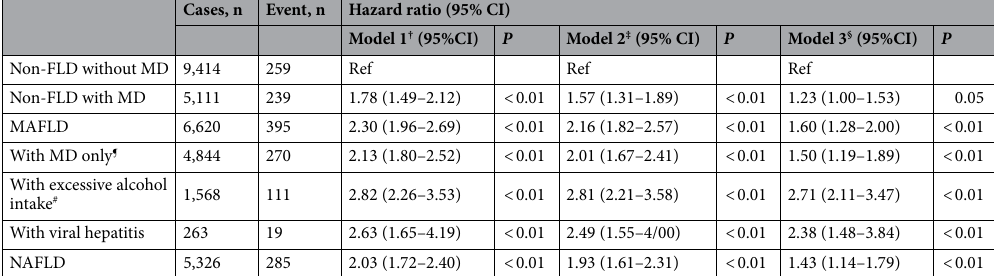
Table 4. Associations between alcohol, viral hepatitis and the incident CKD in subjects with MAFLD or NAFLD. The MAFLD group consists of both-FLD (n = 4,844; same as MAFLD with MD only group) and MAFLD-only (n = 1,776) groups, and the NAFLD group consists of both-FLD (n = 4,844) and NAFLD only (n = 482) groups. CI confidence interval, CKD chronic kidney disease, MAFLD metabolic dysfunction– associated fatty liver disease, NAFLD nonalcoholic fatty liver disease. † Model 1 was crude. ‡ Model 2 was adjusted for age and sex. § Model 3 was adjusted for age, sex, estimated glomerular filtration rate, smoking, physical activity, prediabetes, diabetes, hypertension, cardiovascular disease, NAFLD fibrosis score, body mass index. ¶ Subjects with MAFLD who did not drink excessively and did not have viral hepatitis. # Excess consumption of alcohol was defined as more than 20 g daily of alcohol consumption in men and more than 10 g in